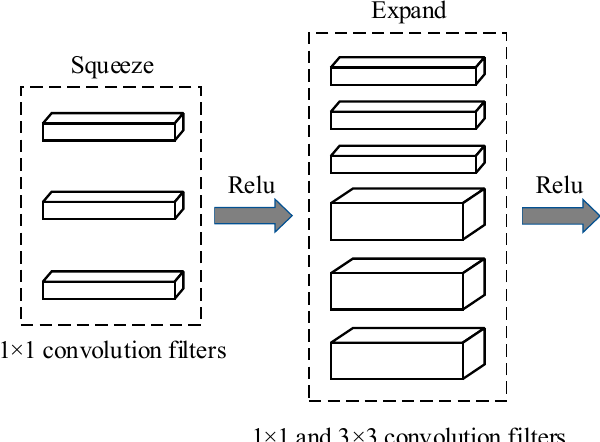
Figure 4. Micro-architectural view: Convolution filters organization in the Fire modules.